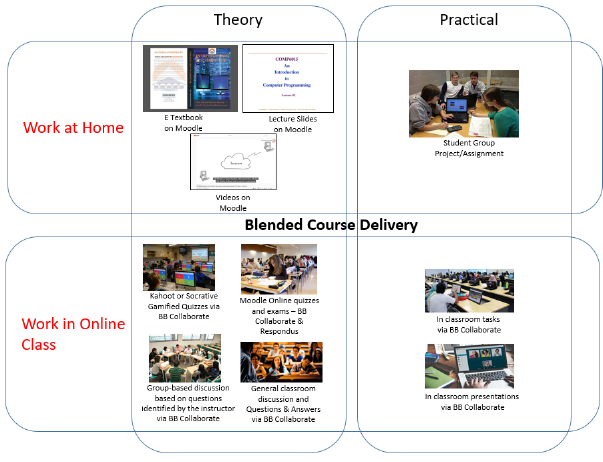
Figure 2. Blended Teaching Methodologies (BTM)